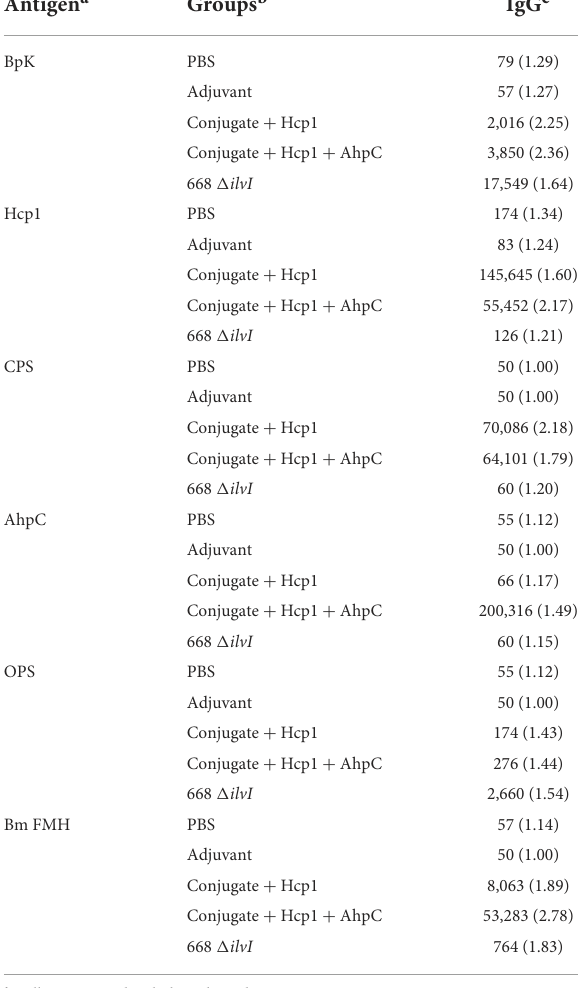
TABLE 2 Total IgG response 6 days post-vaccination (day 44) in C57BL/6